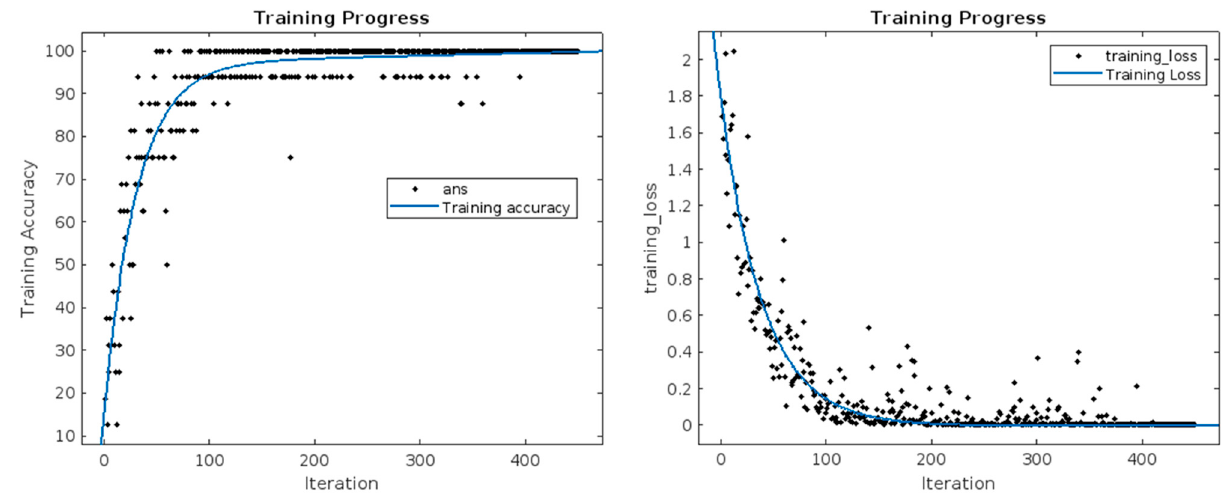
Figure 7. Training progress, and loss of CNN-LSTM network.